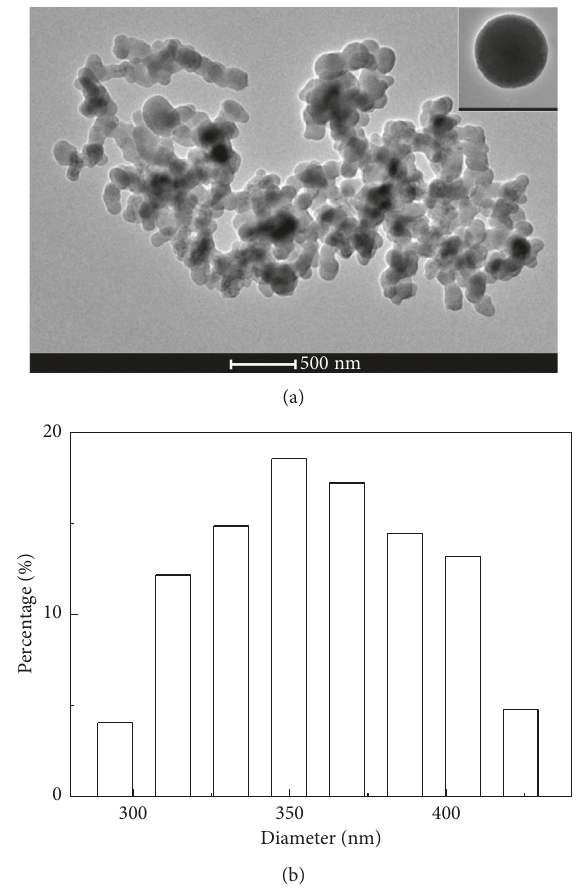
Figure 3: TEM image (a) and PSA histogram (b) of CdTe-QDs@